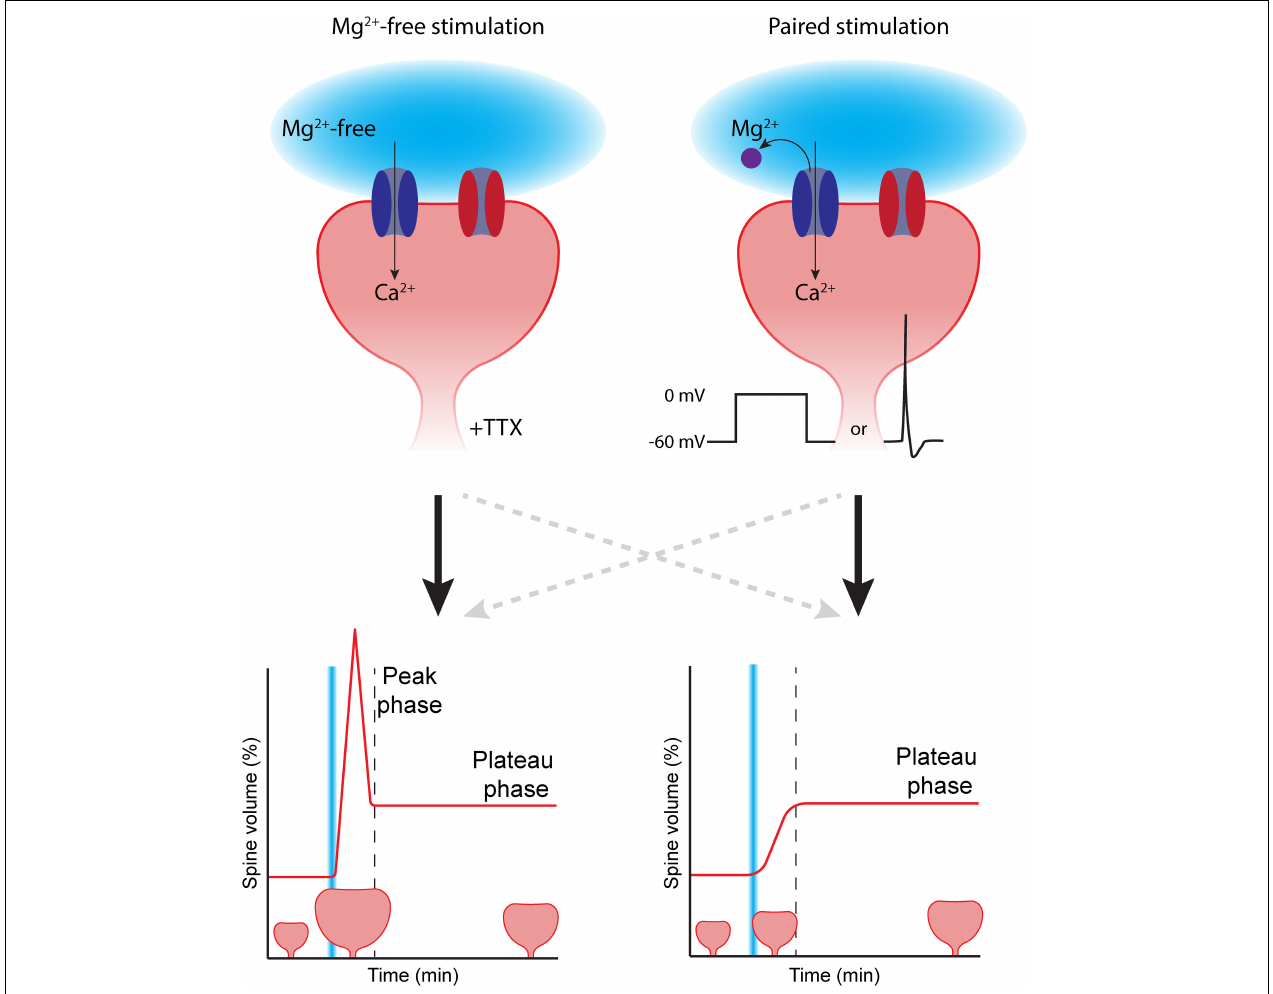
FIGURE 1 | The choice of LTP induction method can affect spine growth. To induce spine growth and functional LTP in single synapses, activation of NMDA receptors (dark blue) is required. Removing the magnesium block (purple) from the NMDA channel pore can be achieved in two ways: (Left) glutamate uncaging (light blue) is performed in the absence of extracellular magnesium (Mg 2 + -free). In this case, tetrodotoxin (TTX) is added to prevent aberrant plasticity due to spontaneous activity. This type of stimulation typically induces rapid, strong initial growth (peak phase), after which the spine volume stabilizes at a lower level (plateau phase). (Right) In paired protocols, two-photon glutamate uncaging (light blue) is paired with depolarization (in voltage clamp by increasing the holding potential, or in current clamp by inducing a backpropagating action potential). Paired stimulation typically leads to a gradual growth of the dendritic spine over time. AMPA receptors in the spine head are depicted in red. The dashed gray lines reflect that the correlation between stimulation protocol and temporal profile of spine growth is not